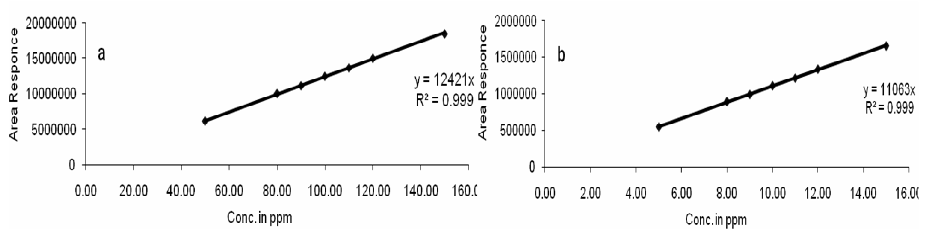
Figure 1. Linearity of (a) methyl paraben and (b) propyl